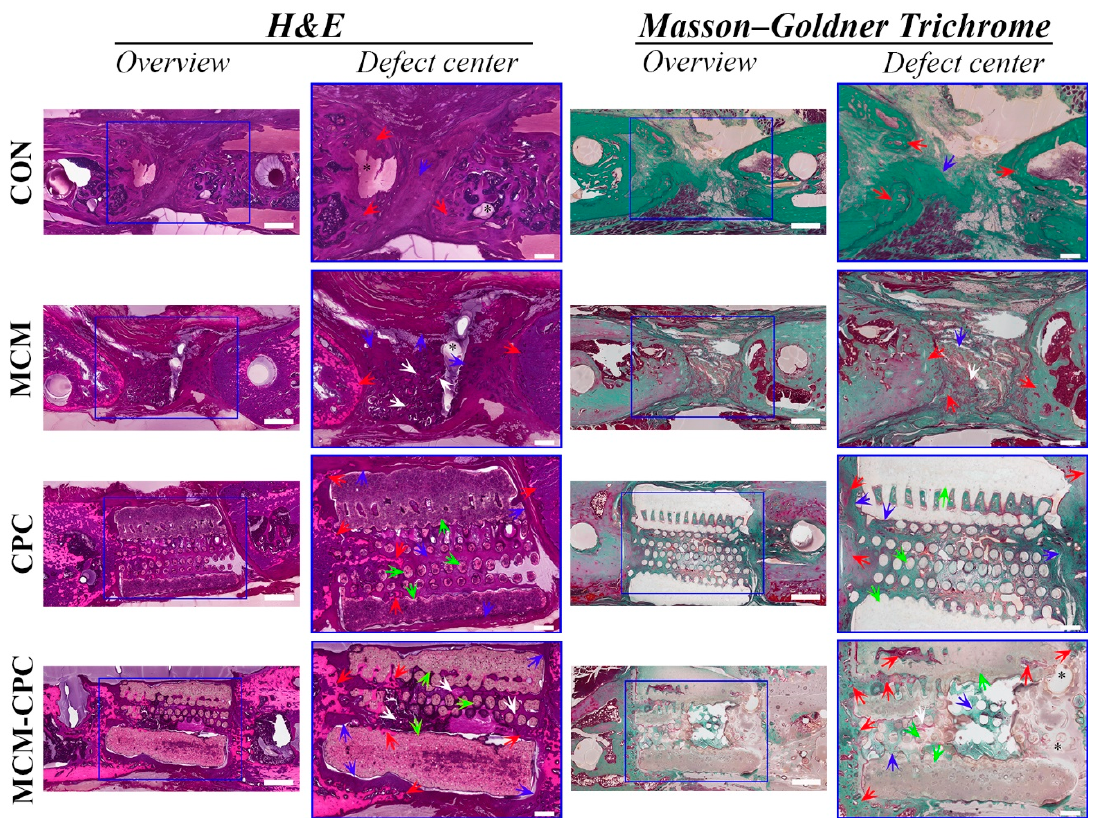
Figure 6. Representative H&E and Masson–Goldner stained sections of the defect area at week 8 weeks post-surgery (red arrows: bone, blue arrows: fibrous tissue, green arrows: remaining CPC, white arrows: remaining MCM; overview scale bars = 1 mm, defect center scale bars = 400 µm).